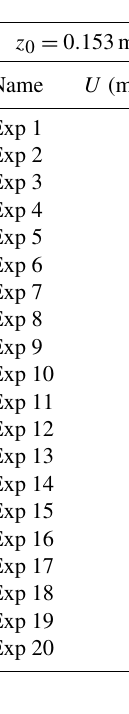
Table 1. List of numerical experiments with z 0 = 0 . 153mm for Exp (1–20) in wind tunnel experiments (Zhang and Shao, 2014) and z 0 = 0 . 76mm for Exp (21–35) in field observations (Bergametti et al., 2018) for the sand